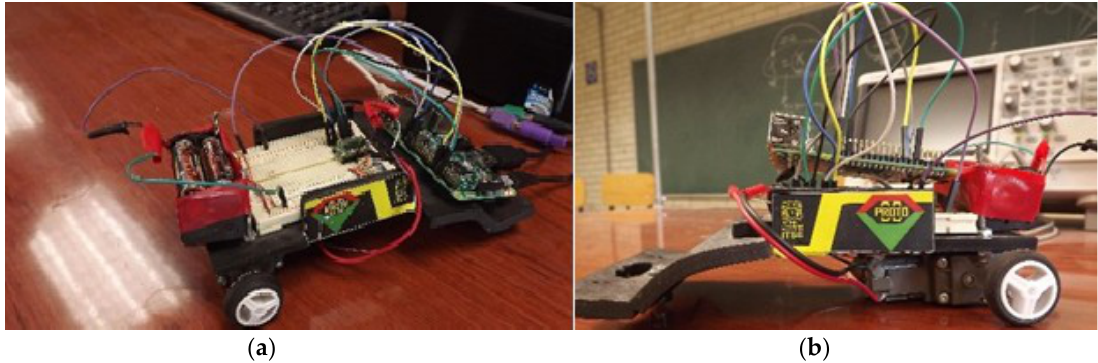
Figure 6. Prototype of the controllable entity, ( a ) seen from above, ( b ) seen from the side.